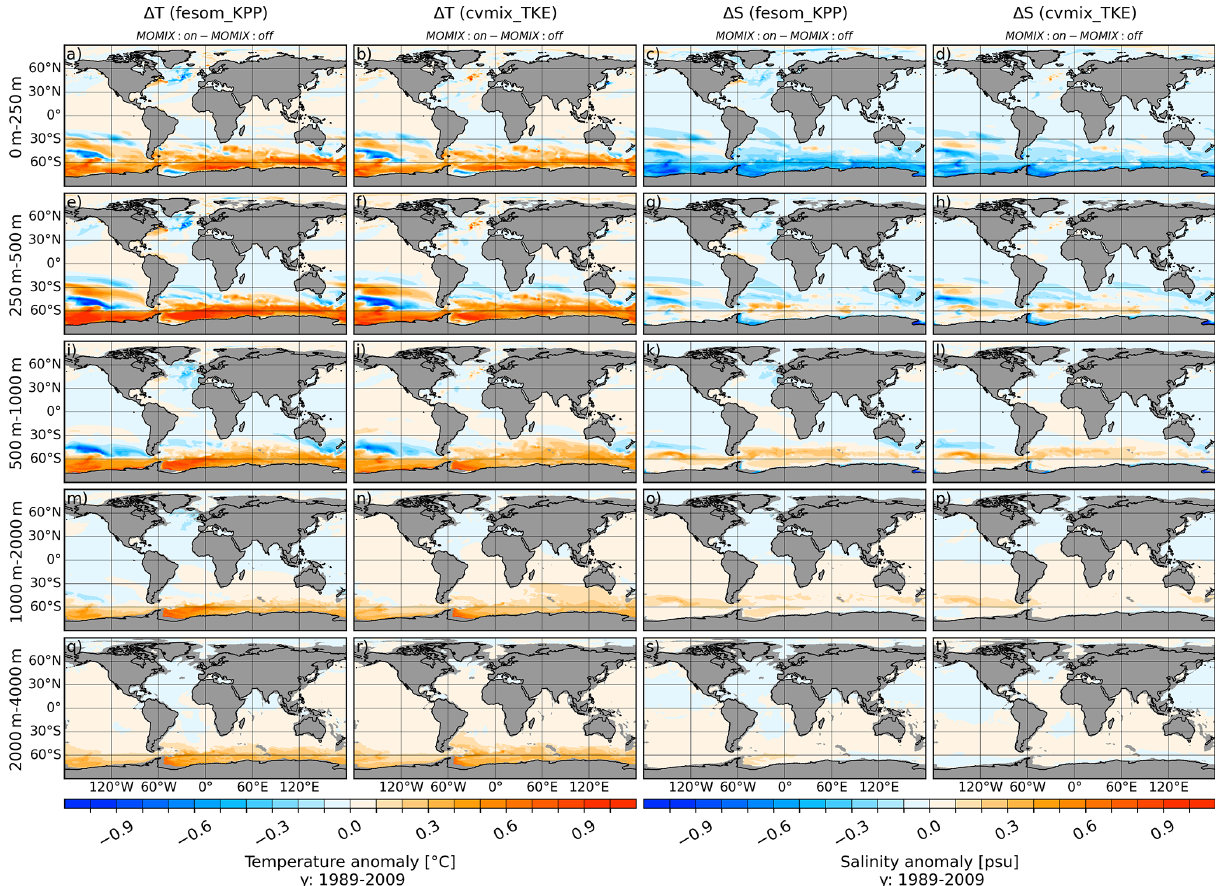
Figure 20. Temperature ( a, e, i, m, q ) and salinity ( c, g, k, o, s ) difference between fesom_KPP with and without the Monin–Obukhov vertical mixing parameterisations (MOMIX) as well as the temperature ( b, f, j, n, r ) and salinity ( d, h, l, p, t ) difference between cvmix_TKE with and without MOMIX averaged for the period 1989 to 2009. The panels show, from top to bottom, the vertically averaged fields for the depth